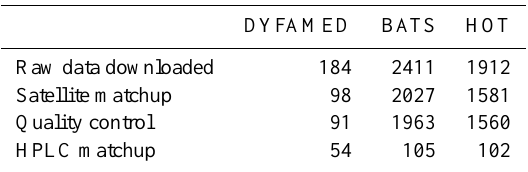
Table 2. Quantity of fluorescence profiles available after each step of the data